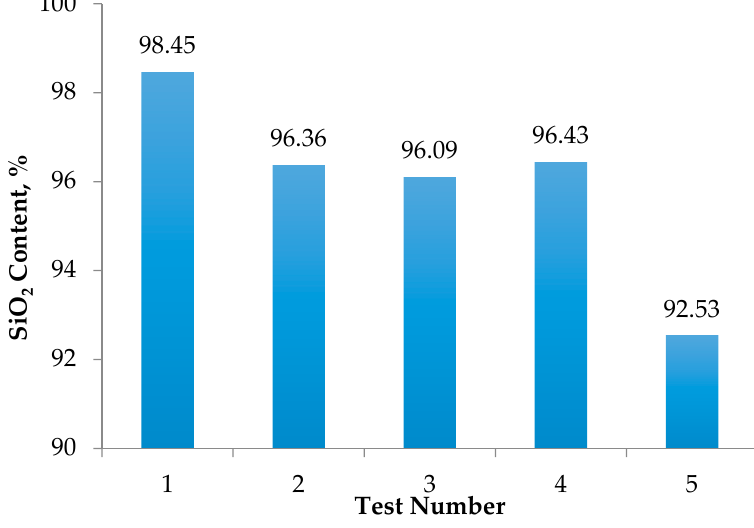
Figure 8. SiO 2 content of quartz concentrates for each test.